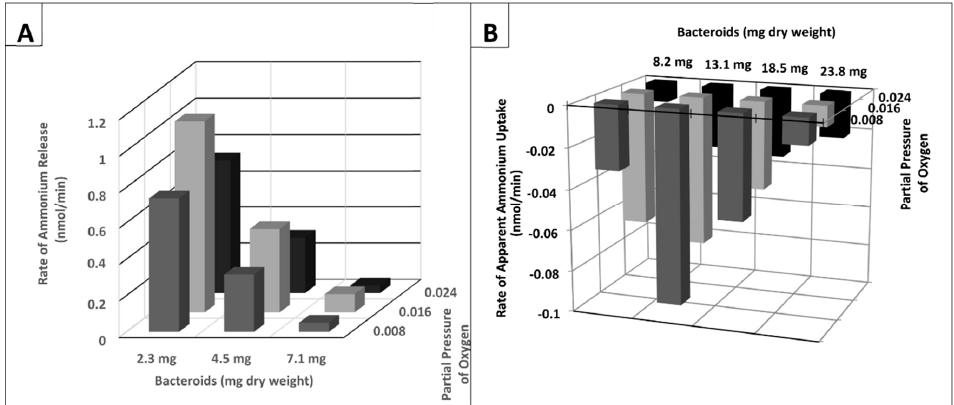
Figure 3. Ammonium release and apparent uptake from ex planta B . diazoefficiens bacteroids as a function of bacteroid amount and partial pressure of oxygen. ( A ) Ammonium release from bacteroids. ( B ) Apparent ammonium uptake of bacteroids. Note the inverted orientation of Panel B is to emphasize the difference between ammonium release ( A ) and apparent ammonium uptake ( B ) as a function of bacteroid amount. Each column color represents a set of measurements at the same partial pressure of oxygen. Variation of the means among duplicates was ≤ 12.0%. All assays contained 2 mM L -malate. Each assay was performed in duplicate as described in Section 4. The experiment shown is representative of eight independent experiments each with different ranges of bacteroid densities, partial pressures of oxygen and concentrations of L -malate.